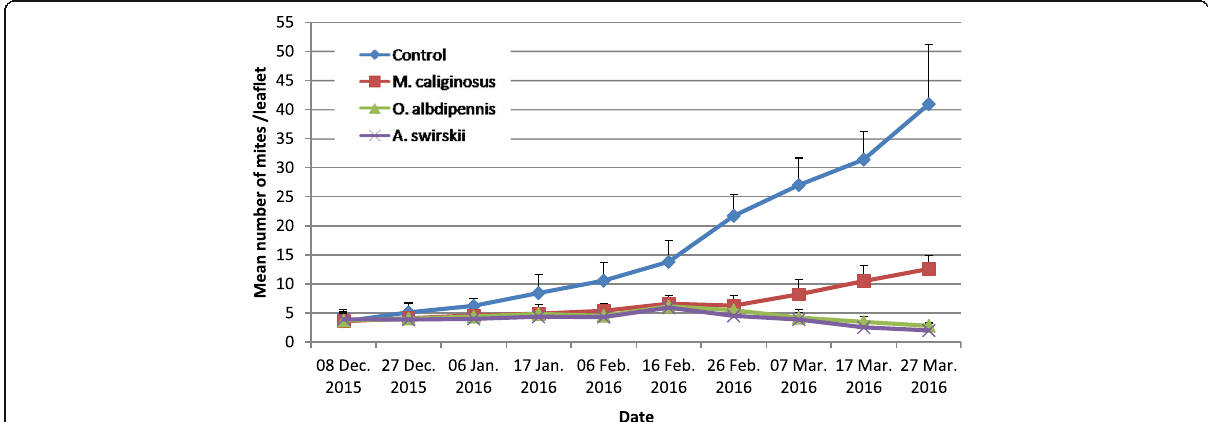
Fig. 1 Mean numbers of T. urticae /leaflet after releasing three different predators ( O. albidipennis , M. caliginosus , and A. swirskii ) on the sweet